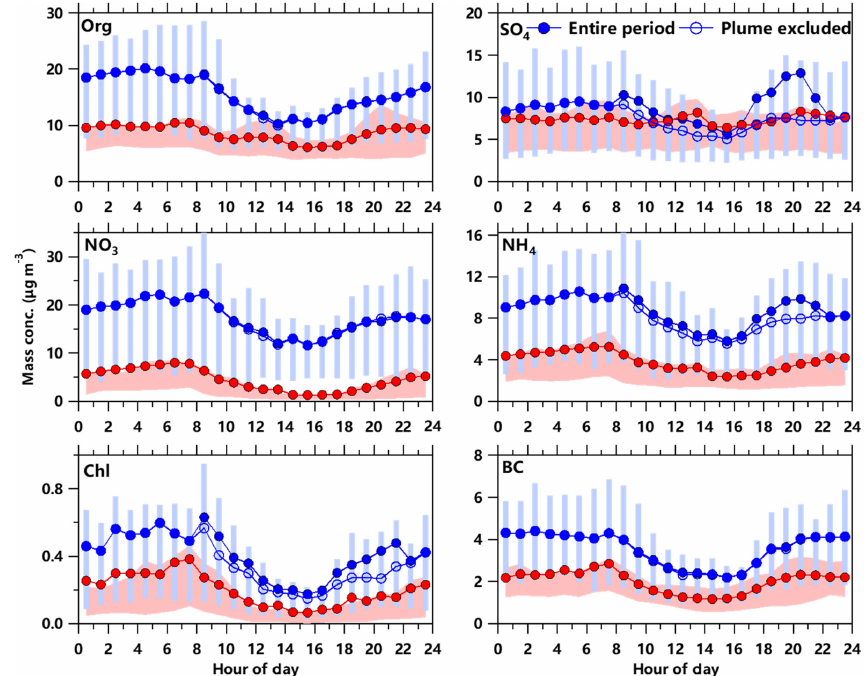
Figure 3. Average diurnal variations in mass concentrations of chemical species in PM 2 . 5 in September 2018 (red) and March 2019 (blue), respectively. The shaded areas and error bars indicate 25th and 75th percentiles. Also, the diurnal cycles of aerosol species, by excluding the periods with the influences from steel plants in March, are shown as blue open